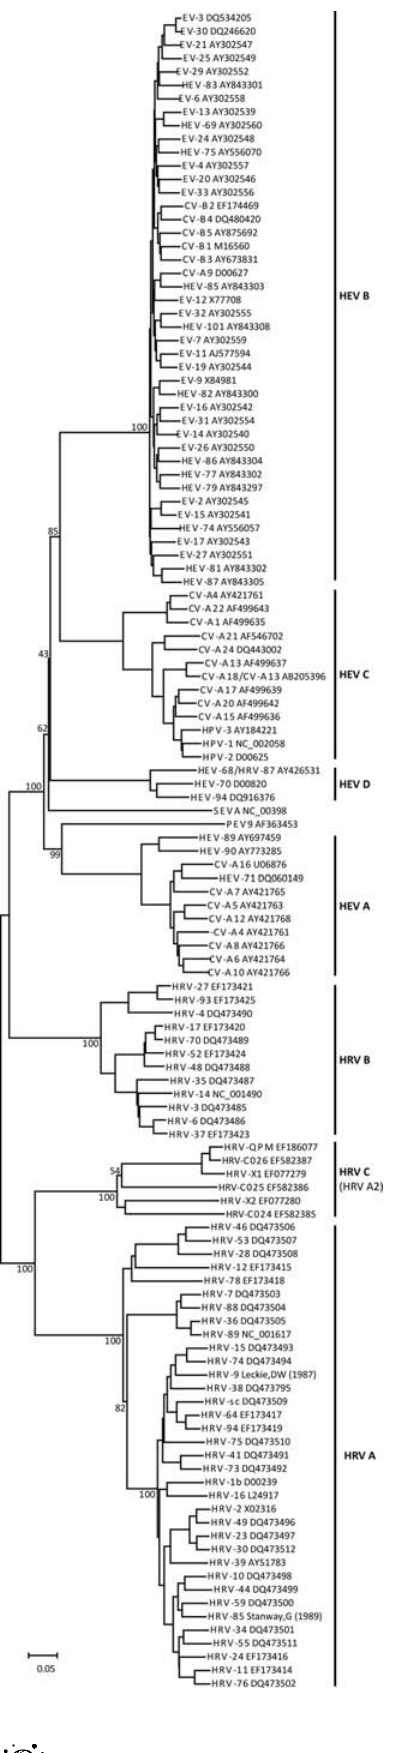
r Figure 6. Neighbour-joining phylogeny based on representa- tive full-length picornavirus polyprotein sequences. Trees are unrooted and relevant nodes are labelled with bootstrap values (%) (see materials and methods for details). Species are indicated next to vertical bars. CV-Coxsackievirus A; EV-Echovirus; HEV-Enterovirus;